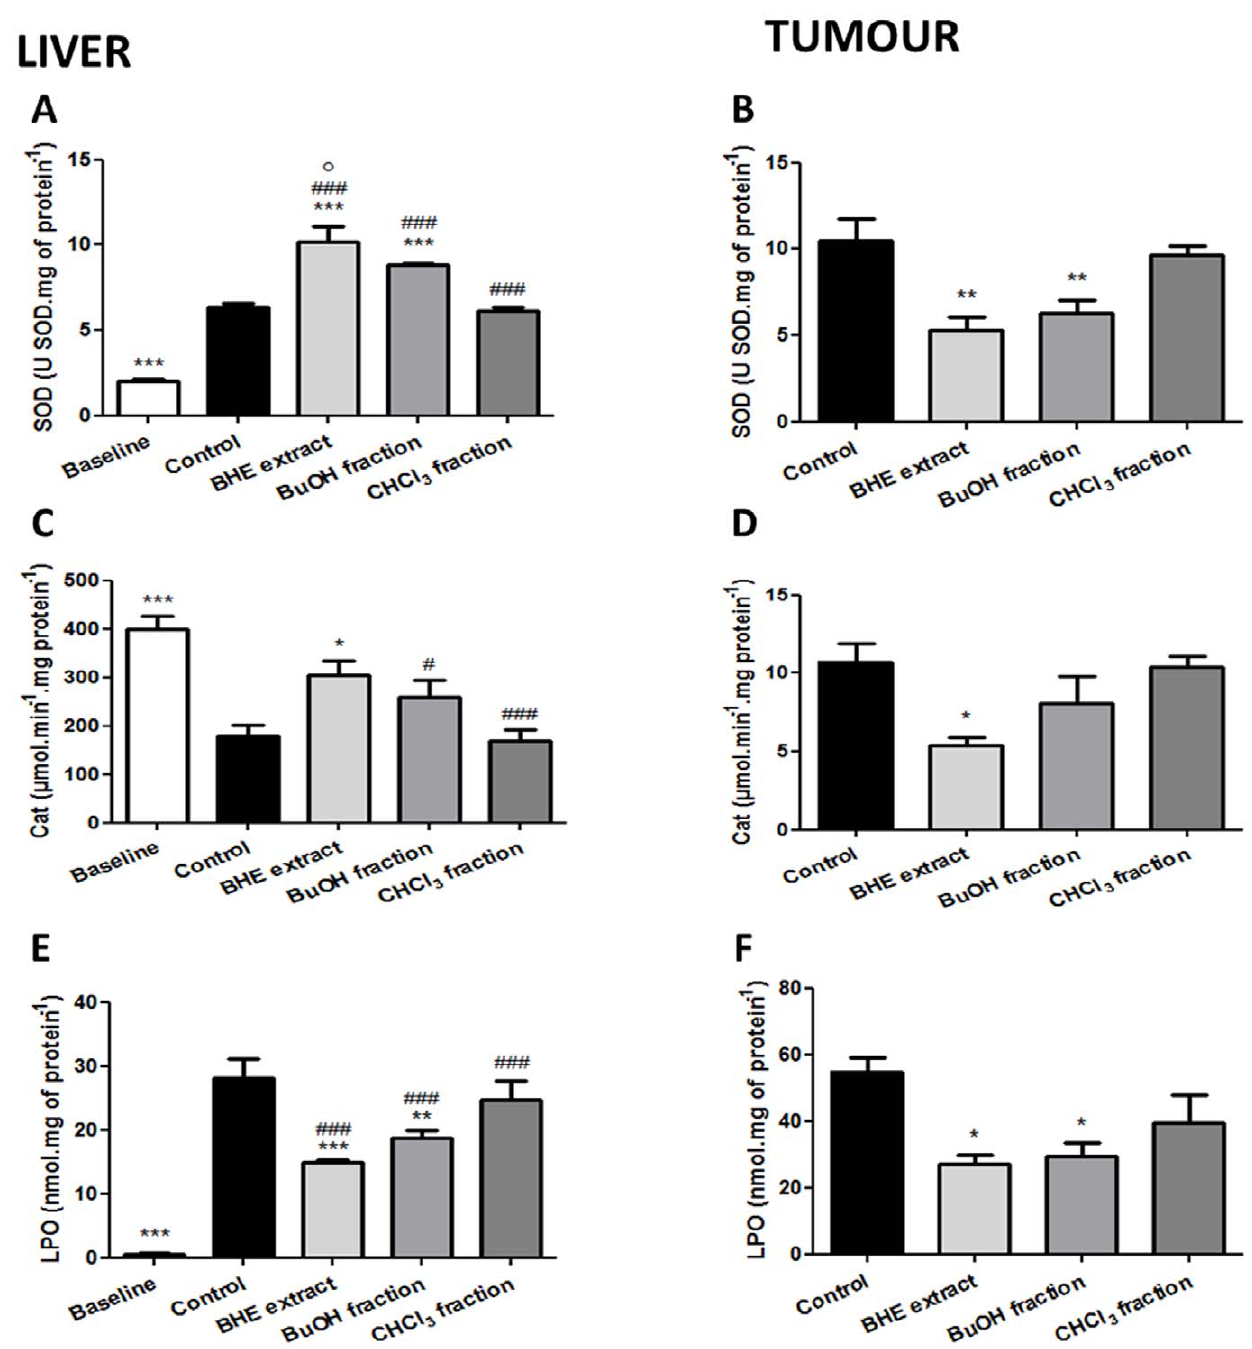
and tumour (F). Symbols: * p , 0.05; ** p , 0.01 and *** p , 0.001 as compared to the control group; # p , 0.05 and ### p , 0.001 as compared to the baseline group; u p , 0.05 as compared to the BuOH